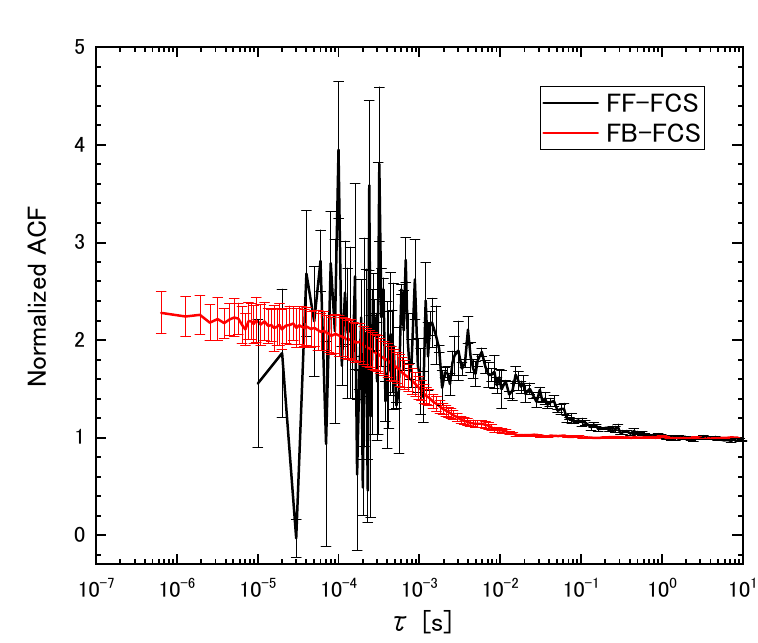
Figure A2. Normalized autocorrelation function (ACF) measured by FF-FCS and FB-FCS. Error bars show standard error ( n = 3). The sample was of fluorescent latex beads with a diameter of 20 nm (FluoSpheres, F13081, Molecular Probes, USA). The measurement duration were 100 s and 10 s for FF-FCS and FB-FCS, respectively. The excitation laser power at the focal plane of the focusing lens were 7.29 µ W and 2.93 µ W for FF-FCS and FB-FCS, respectively.